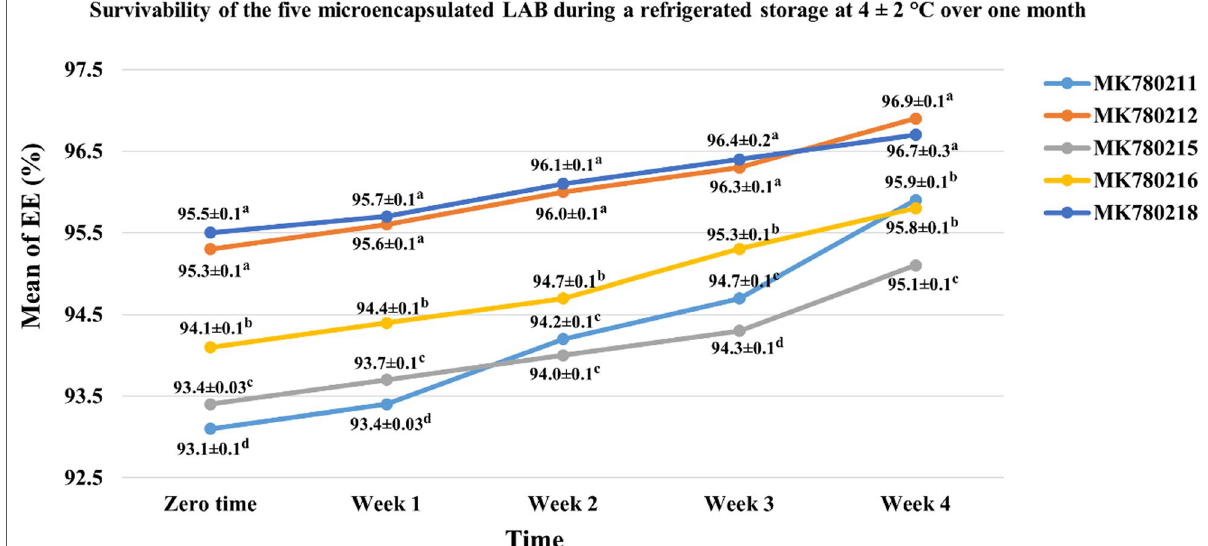
Fig. 5 Survivability of the five microencapsulated LAB during a refrigerated storage at 4 2 °C. Data are represented as weekly bacterial cell counts ± during one month for each strain. Data were expressed as mean ( STD). Uppercase letters are results of Tukey test. a − d Means with the same letter ± are not significantly different at sig. ( p ≤